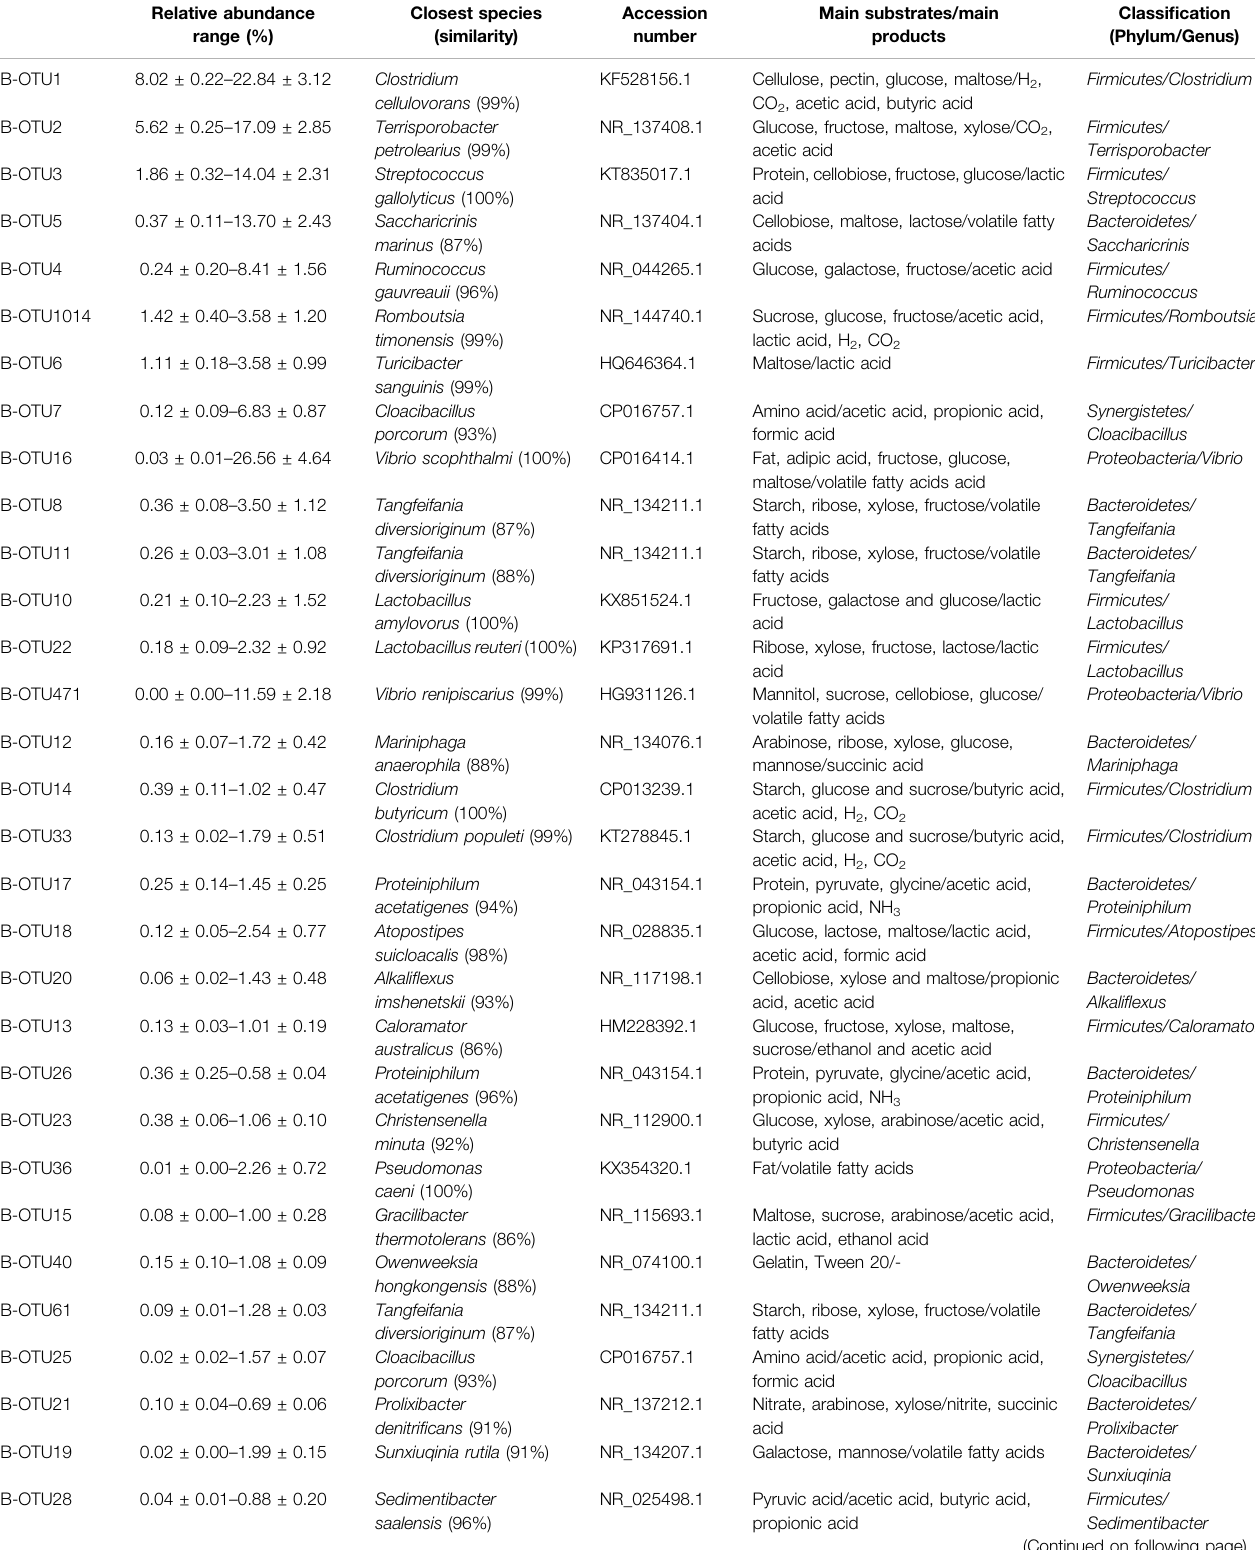
TABLE 3 | The classi fi cation and function information of the most dominant 35 bacterial species. Relative abundance range